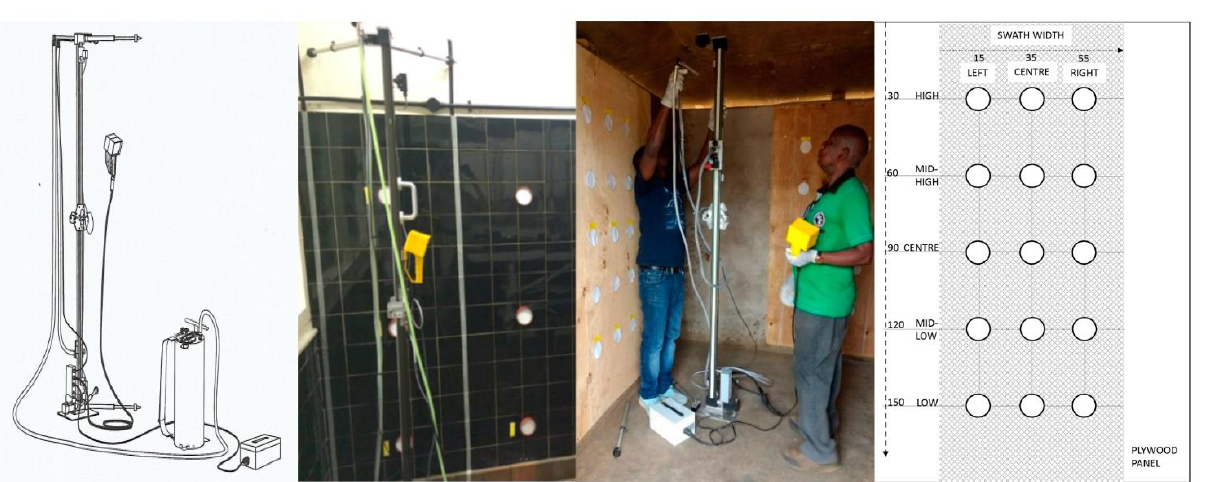
Figure 1. A schematic overview of the sprayer adapted from the Micron product manual is shown on the ( left ). A photo showing the set-up of track sprayer in the lab ( centre left ) and in an experimental hut ( centre right ) is shown, and a schematic overview of the filter paper positions on plywood panels, with values in centimetres, is shown on the ( right ).